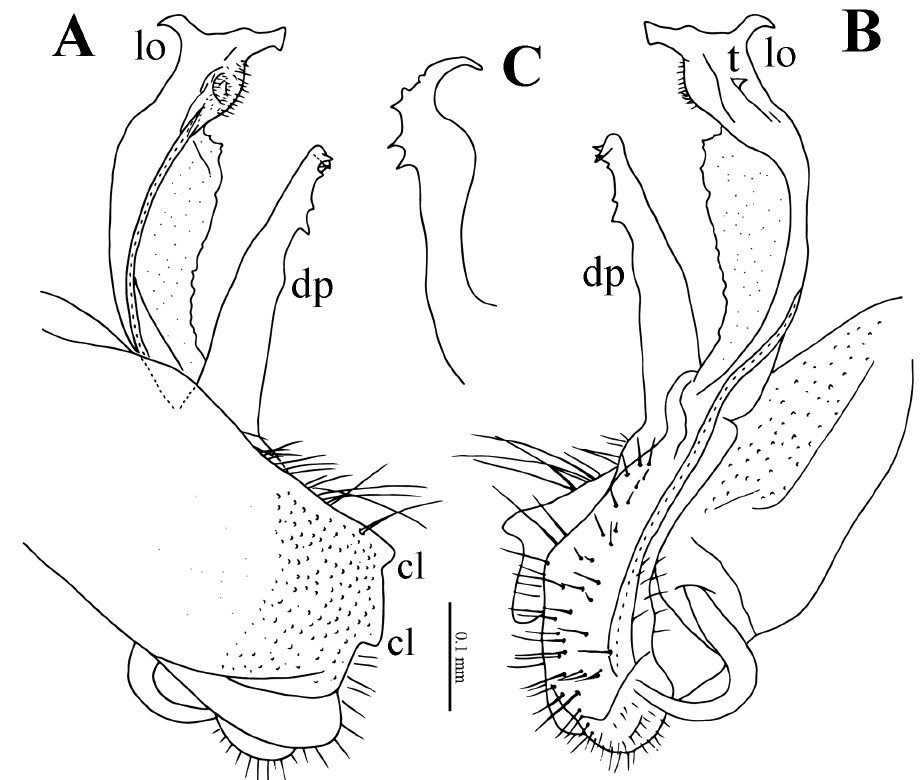
Figure 10. E. paraster sp. n., male holotype from Cave Tham Long Puang. A–B right gonopod, lateral and mesal views, respectively C distofemoral process, subventral view. Abbreviations: cl = coxal lobe; dp = distofemoral process; lo = lobule; t =